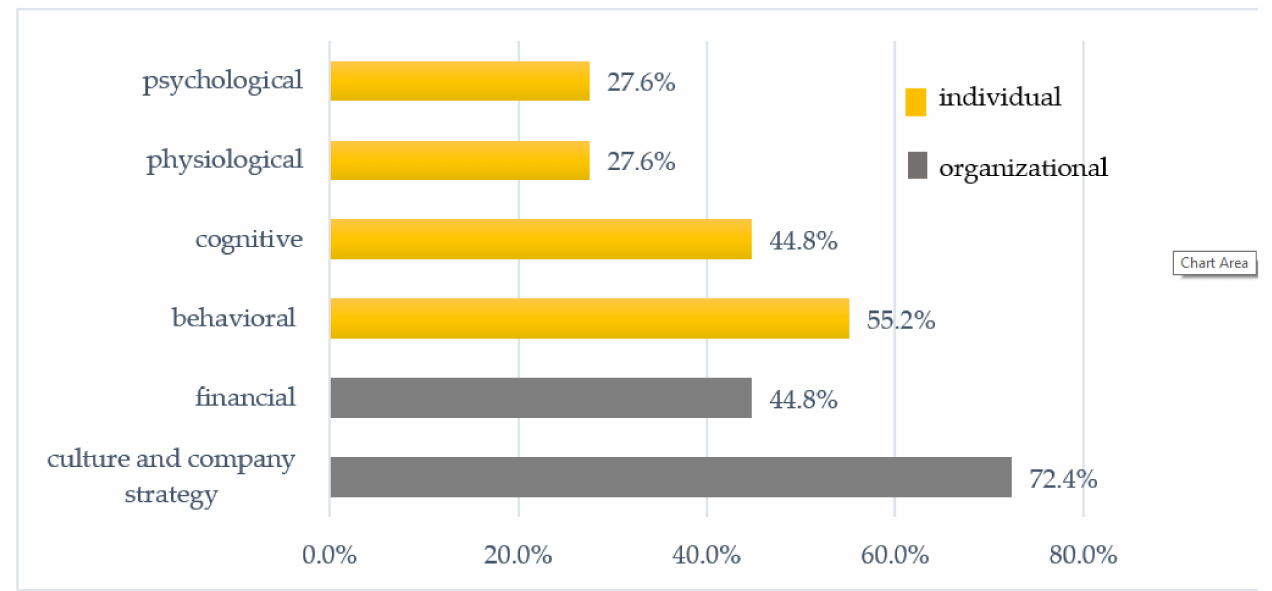
Figure 3. Organizationalandindividualoutcomesofhealthpromotionprogramsintheentitiesstudied. Source: Author’s